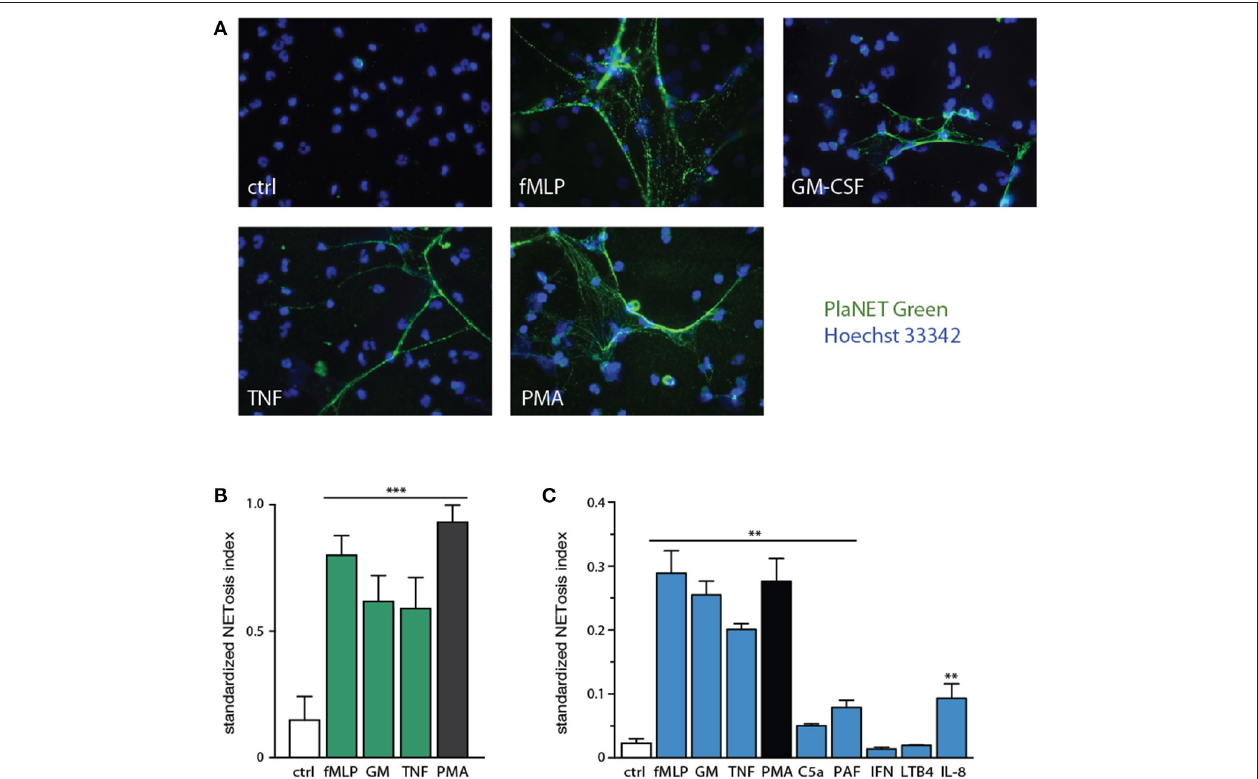
FIGURE 3 | Relative potency of physiological neutrophil agonists or PMA to induce NETosis. (A) Neutrophils cultured on poly-L-lysine-coated coverslips were incubated for 4h in the absence (“ctrl”) or presence of 30nM fMLP, 1nM GM-CSF, 100 U/ml TNF α , or 50nM PMA. NETosis was then assessed using PlaNET Green as described in Methods . Representative fields are shown at 40X magnification. (B) Quantitative representation of the above experiments, in which PlaNET Green fluorescence values were standardized according to total cell number (i.e., the number of individual events detected using a cell-permeable nuclear stain), thus yielding a NETosis index. Mean ± s.e.m. from at least 5 independent experiments. *** p < 0.001 vs. unstimulated cells. (C) Neutrophils were cultured as described above for 4h in the absence (“ctrl”) or presence of 30nM fMLP, 1nM GM-CSF, 100 U/ml TNF α , 50nM PMA, 30nM C5a, 50nM PAF, 100 U/ml IFN γ , 100nM LTB4, or 10nM IL-8. Quantitative representation of these experiments, in which PlaNET Blue fluorescence values were standardized as described in (B) . Mean ± s.e.m. from 3 independent experiments. ** p < 0.02 vs. unstimulated